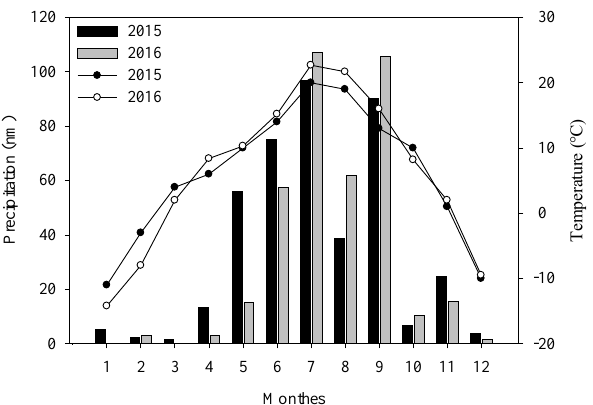
Figure 1. The variations of temperature and precipitation of Wuchuan County in 2015 and 2016.